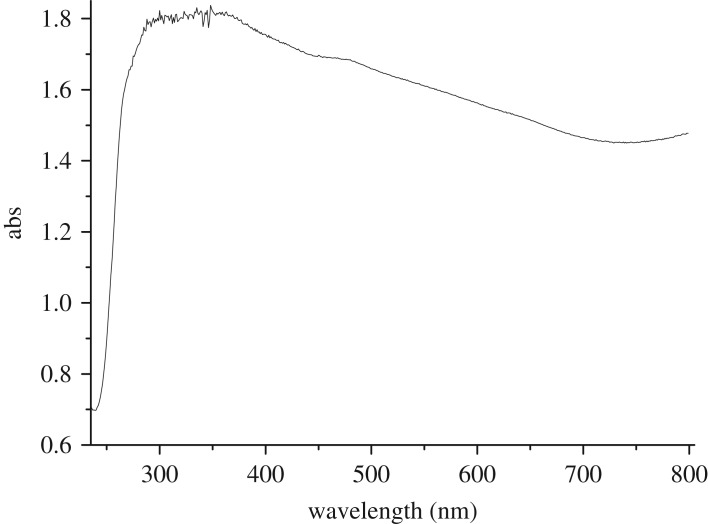
Diffuse reflectance UV–vis spectrum of Fe3O4.